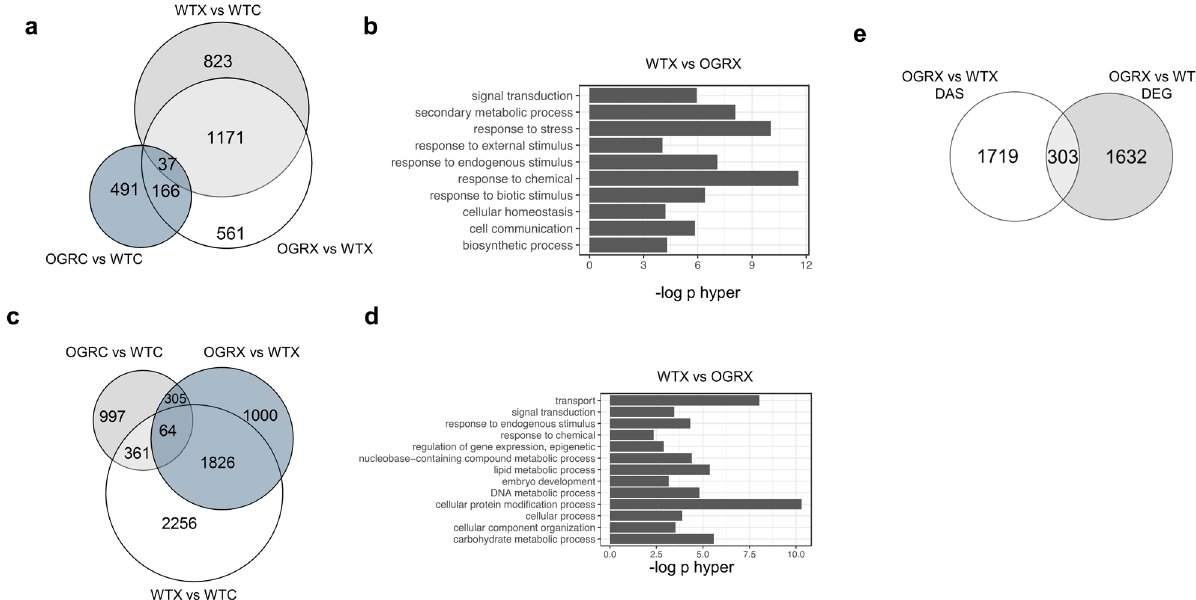
Fig. 4 OGR impedes the effects of GEX1A on global gene expression and splicing patterns. a Overlap of differentially expressed genes (DEGs) between WT and OGR under mock or GEX1A treatment. The number of DEGs much higher in WT compared to OGR . Heterologous expression of PHF5A-Y36C affects the global gene expression under mock conditions. b GO enrichment analysis of the DEGs regulated by GEX1A. c Overlap of differentially spliced events (DAS) between WT and OGR . d GO enrichment of GEX1A-sensitive DAS genes. e Overlap of DEG with DAS events for OGR and WT under GEX1A treatment.